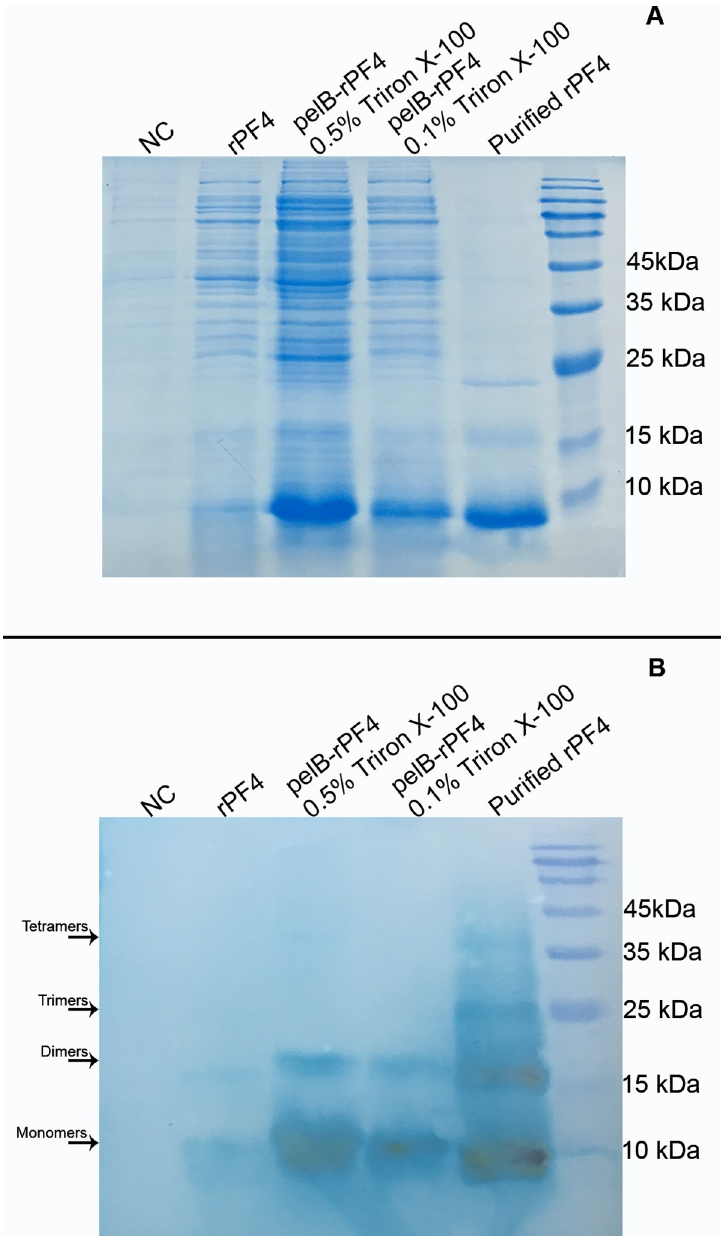
Fig 13. Investigating the formation of higher structural levels by the secreted rPF4. The lanes labeled as rPF4 and pelB-rPF4 represent proteins expressed from the pET26b-rPF4 and pET26b-pelB-rPF4 constructs respectively. The purified rPF4 devoid of any detergents delineates all the oligomeric forms of rPF4; however, in samples containing 0.1% and 0.5% Triton X-100, the monomeric and dimeric states constitute the sole structural states of the secreted proteins. NC represents the negative control and the M denotes the molecular weight